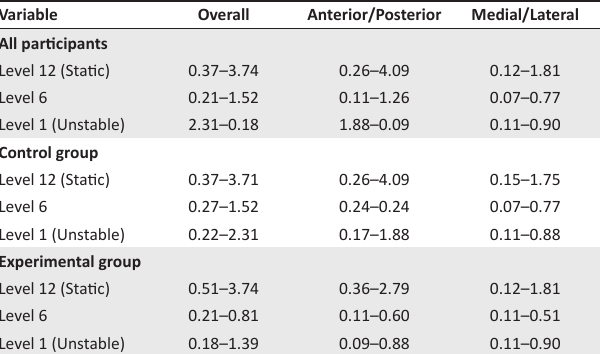
TABLE 4: Reference intervals for postural stability upper trunk in all three planes of movement ( n = 15). Variable